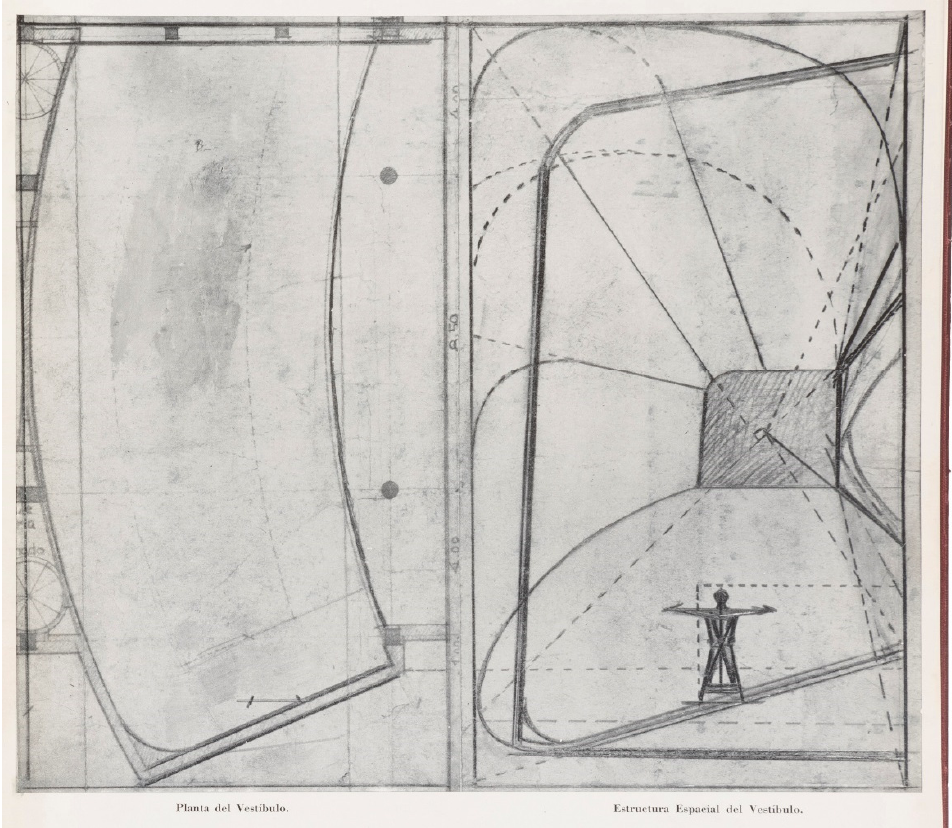
Figure 3. David Alfaro Siqueiros, ‘For a complete social security and for all Mexicans’, drawings from the book Alfaro Siqueiros, David. Mural del Hospital de la Raza . Ocho Láminas, Tres a coloures. México: Public art editions, 1954. Image courtesy of Morton Subastas, México, © DACS 2021.